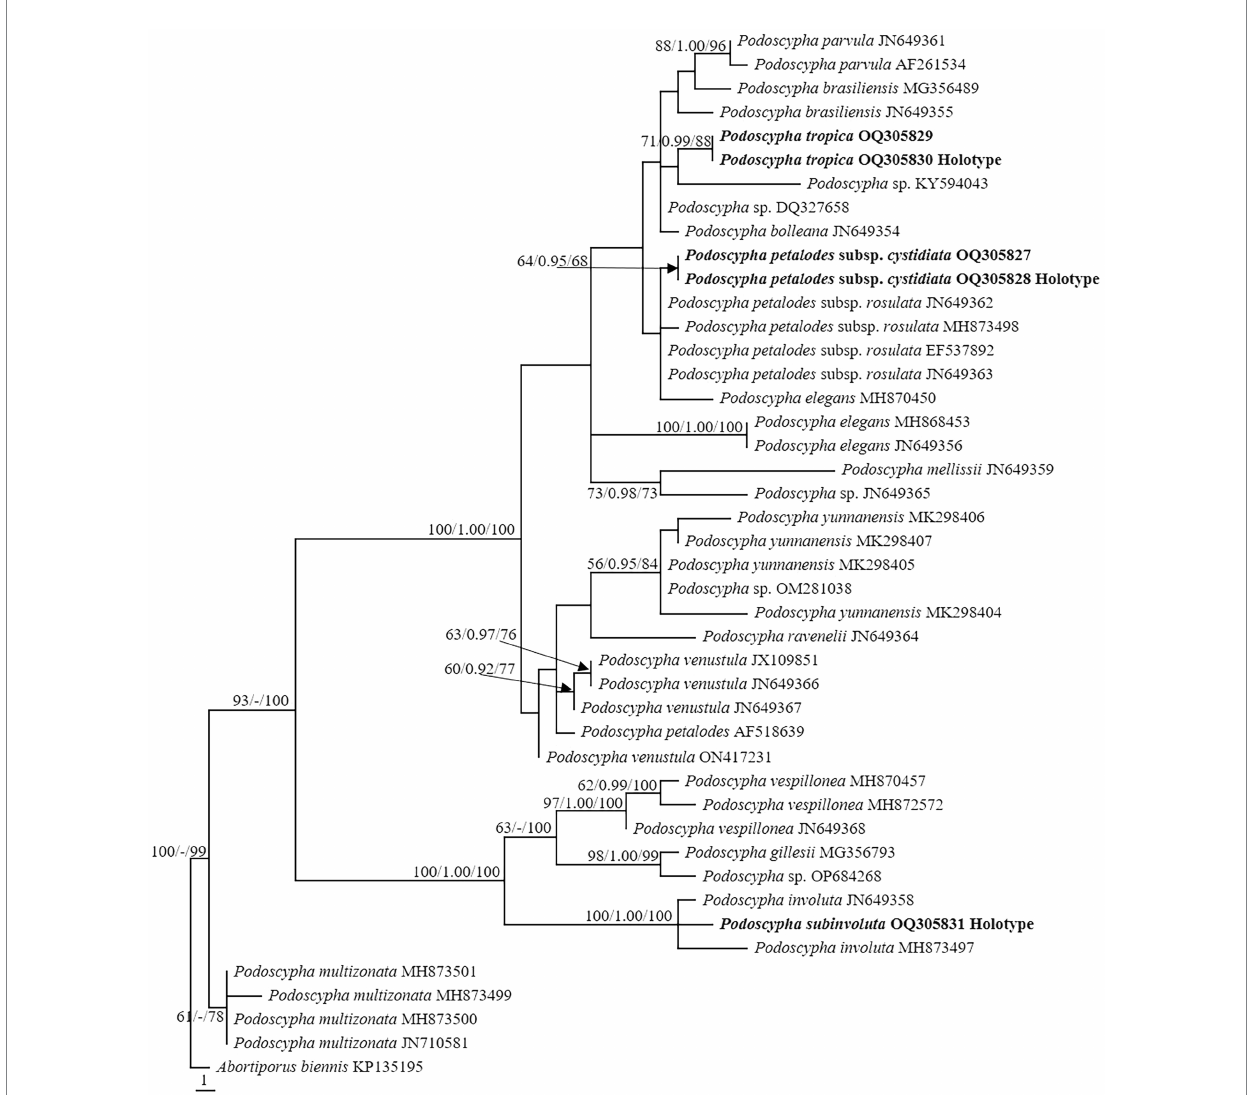
FIGURE 2 Phylogeny of Podoscypha by maximum parsimony (MP) analyses based on nuclear large subunit (LSU) sequences. Branches are labeled with MP bootstrap >50%, Bayesian posterior probabilities >0.95, and maximum likelihood bootstrap >50%. New species and subspecies are indicated in bold.